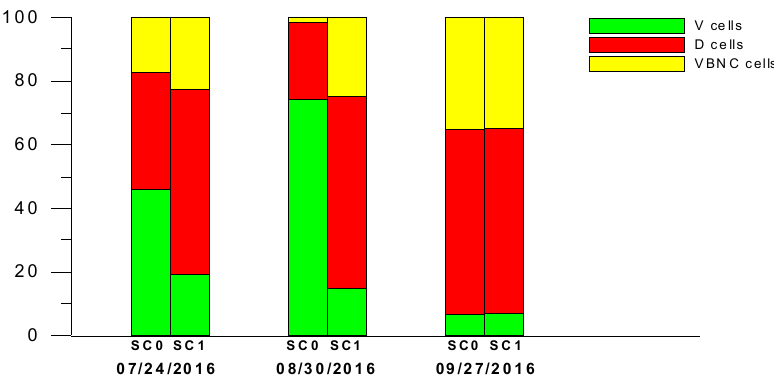
Figure 2. Percentage contribution to total E. coli population of viable (V), dead (D) and viable but not culturable (VBNC) fractions observed at the wastewater discharge (SC0) and monitoring (SC1) sites in Santa Cecilia during summer